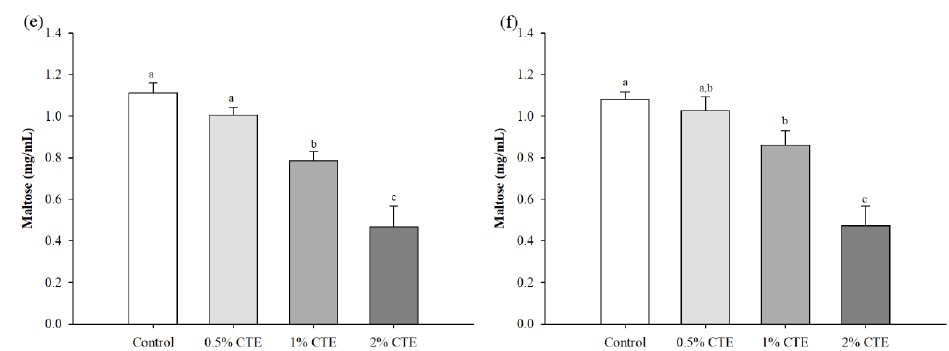
Figure 1. The amount of maltose released from ( a ) potato flour, ( b ) rice flour, ( c ) glutinous rice flour, ( d ) wheat flour, ( e ) corn flour, and ( f ) cassava flour when combination with the different concentrations of CTE against pancreatic α -amylase activity at 10 min. The results are expressed as mean ± standard error of the mean (SEM), n = 4. The different letters denote statistically significant differences in mean values. ( p < 0.05) Mean values with the same superscript letters (a or b) were similar and no statistically significant differences were observed for these samples. CTE— Clitoria ternatea L. flower extract.